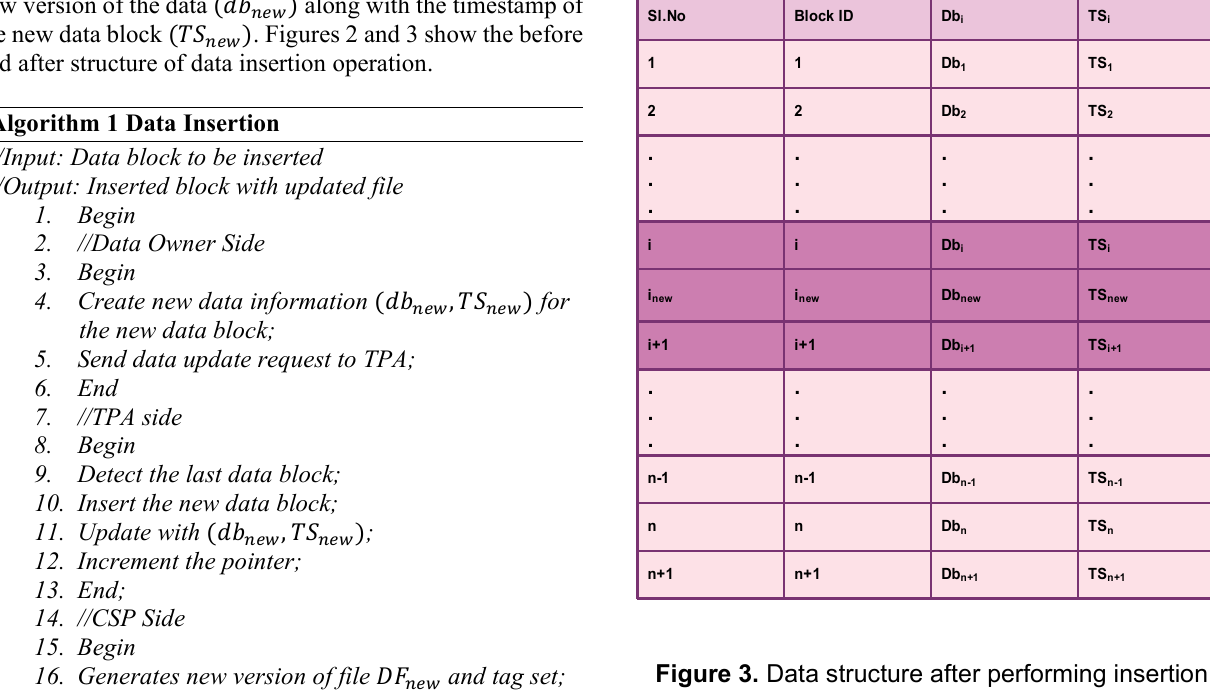
Figure 3. Data structure after performing insertion